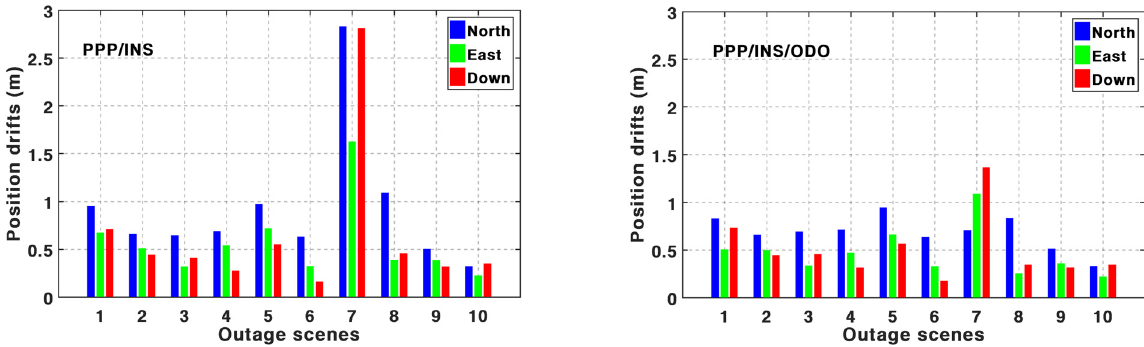
Figure 14. Average maximum position drifts of different GNSS for BSSD PPP/INS TCI ( left ) and PPP/INS/ODO TCI ( right ) on different GNSS outage scenes.